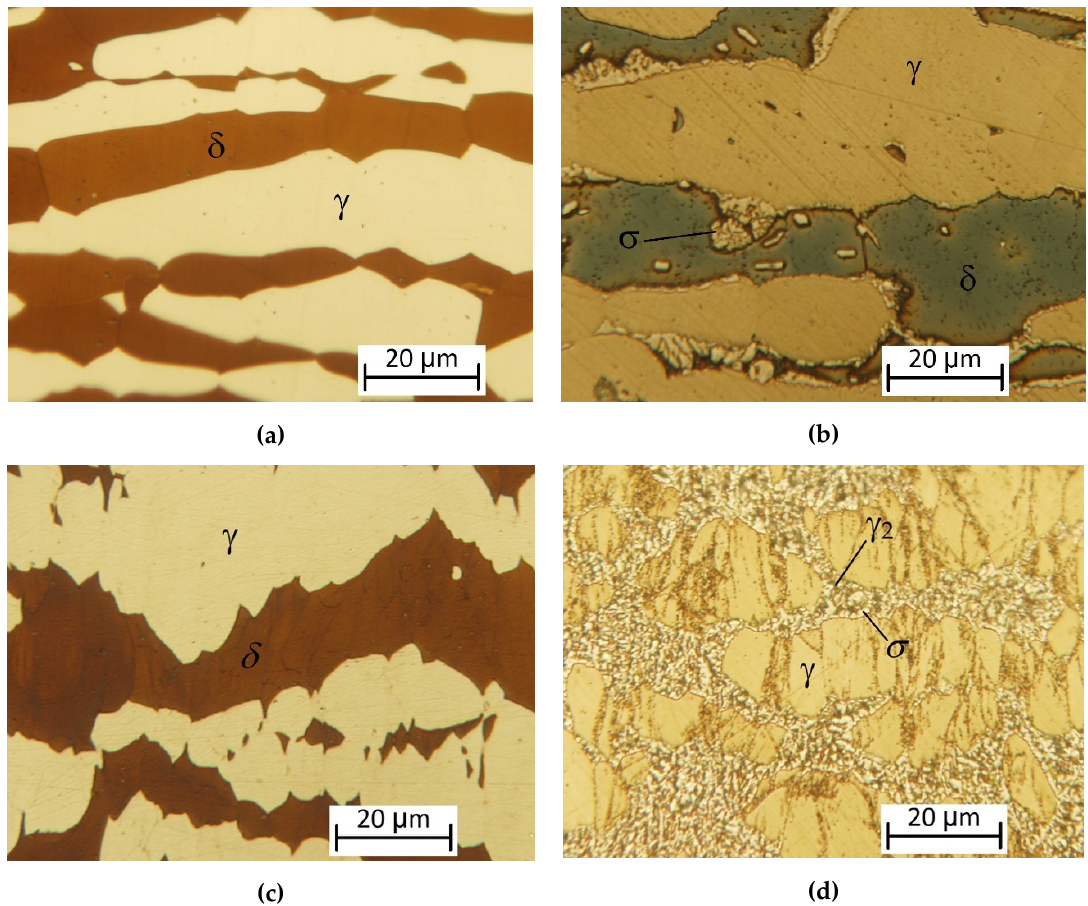
Figure 9. Microscope images of 2507-type SDSS in the magnification of 1000 × : ( a ) Base microstructure of the 2507-type SDSS; ( b ) heat-treated sample at 850 °C without deformation ; ( c ) ε = 61.9% deformed sample without heat treatment; ( d ) ε = 61.9% deformed sample and heat treated at 850 °C.